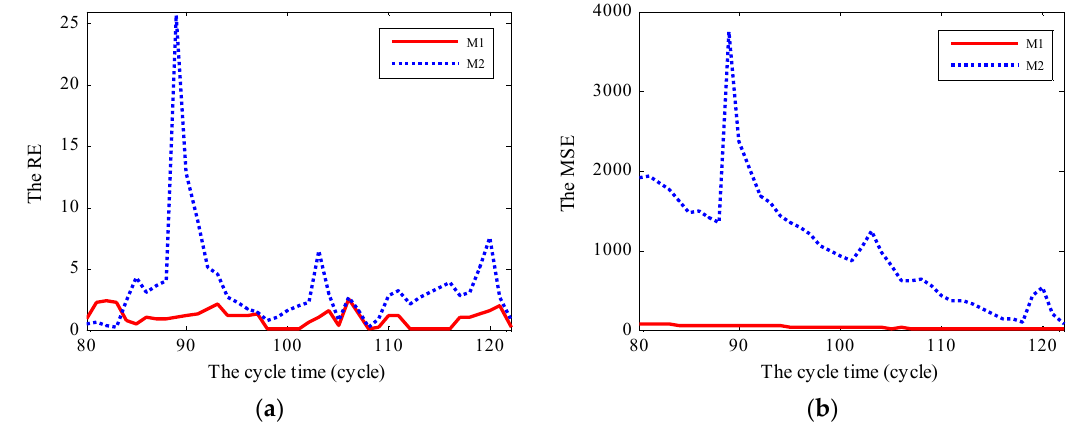
Figure 9. The results of RE and MSE at some time points: ( a ) The RE by M1 and M2; and ( b ) the MSE by M1 and M2.